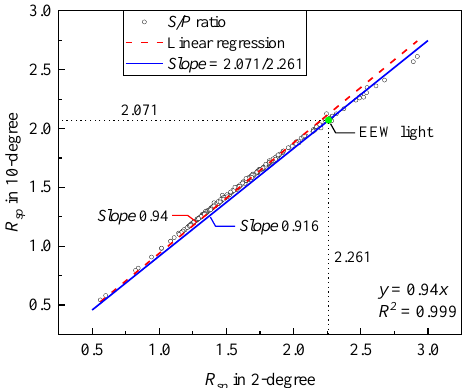
Figure 4. R sp calculated in a plot of the 10-degree against the 2-degree SSC system. The red-dashed line is a linear regression fitting with a slope of 0.94. The blue solid line is a straight line with a slope of 0.916, which is equal to the ratio of the R sp values for EEW light in the 10-degree (2.071) and 2-degree (2.261) systems.